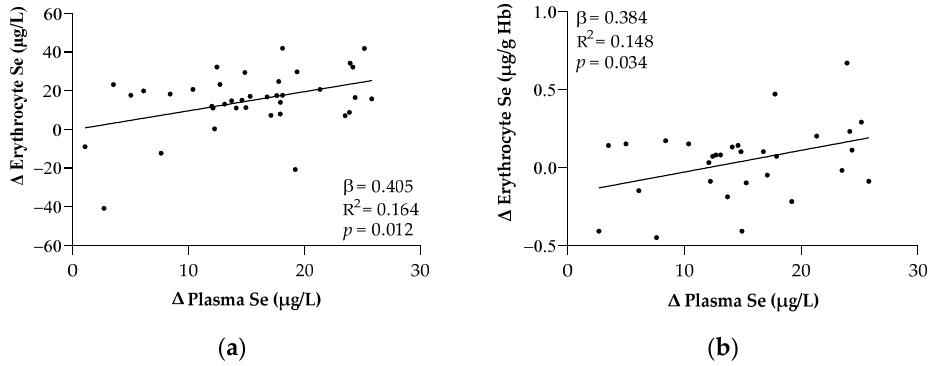
significance was considered for p < 0.05.